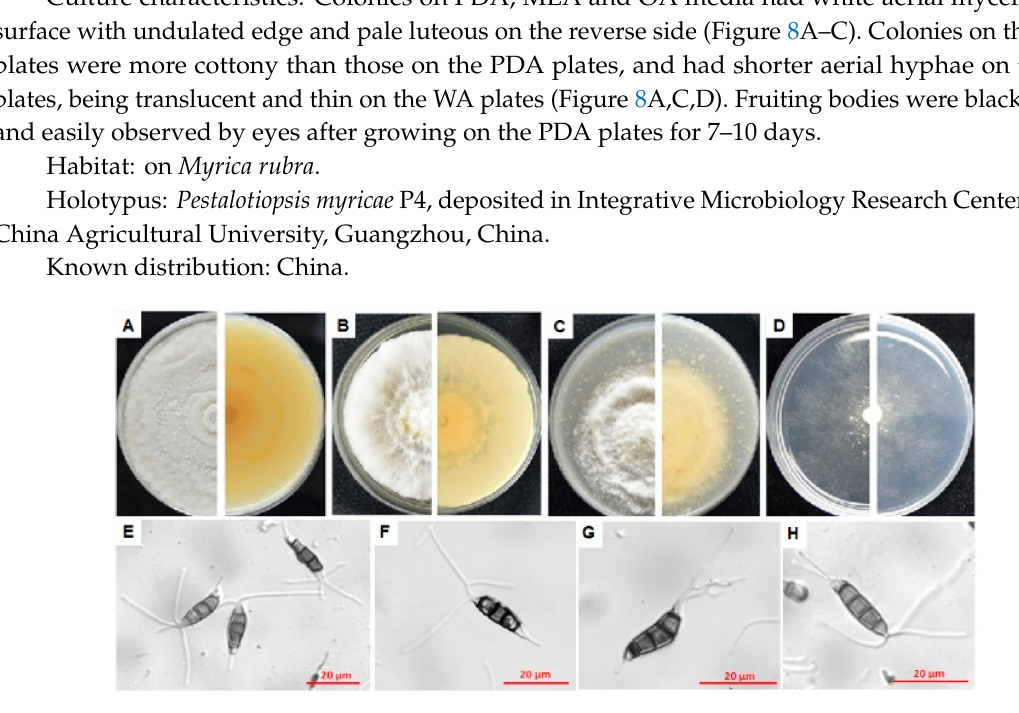
Figure 8. Morphological characteristics of Pestalotiopsis myricae isolate P4. ( A – D ), the front and back of the colony morphology on PDA, MEA, OA and WA plate; ( E – H ), conidia with two ( E ), three ( E , F , H ) or four ( E , G ) tubular apical appendages, and one ( E – G ) or two ( H ) appendages at the basal cell. Conidia were generated on PDA plates after 7 days of culture. Fungal mycelia and spores were observed and photographed with a Zeiss Axio observer Z1 Microscope (Carl Zeiss Microscopy, Germany). Isolate P4 was the same (100% coverage value) as Pestalotiopsis sp. strains LB11, LB12 and